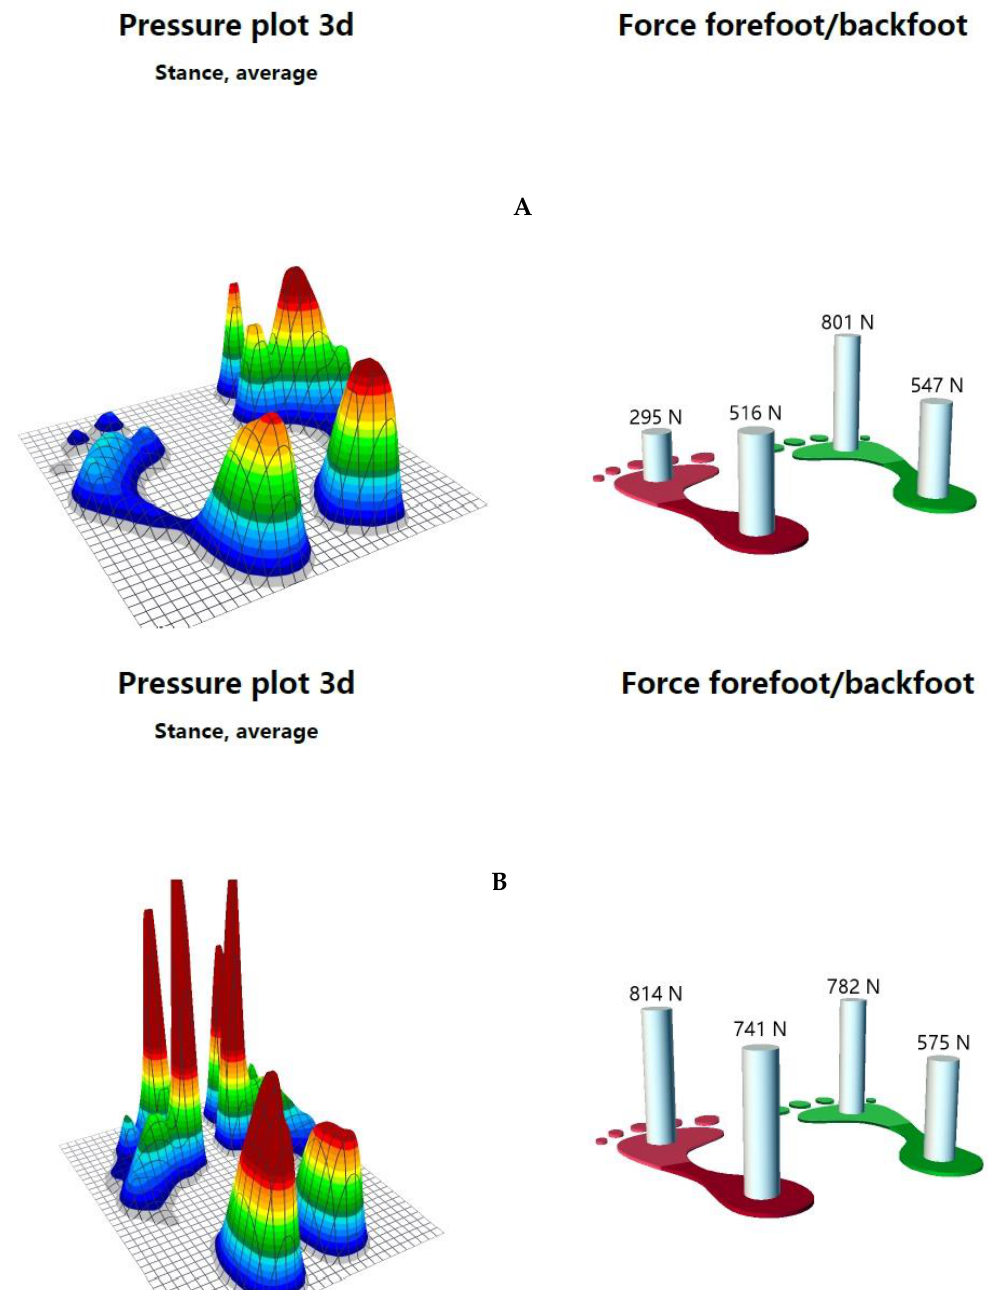
Figure 1. Foot pressure during walking (( A ), before ankle eversion taping; ( B ), after ankle eversion taping).